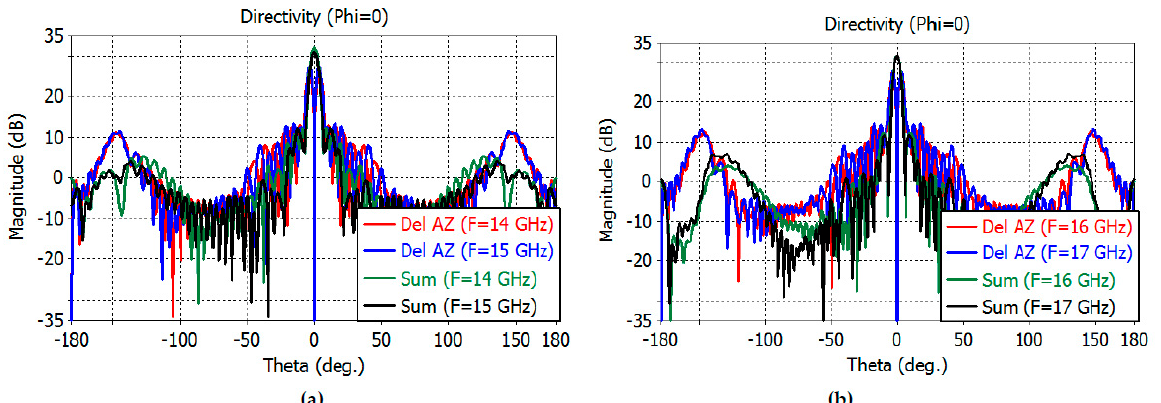
Figure 12. ( a ) E -plane directivity patterns of the reflector at 14-15 GHz ( − 180 ◦ to 180 ◦ ). ( b ) E -plane directivity patterns of the reflector at 16–17 GHz ( − 180 ◦ to 180 ◦ ).